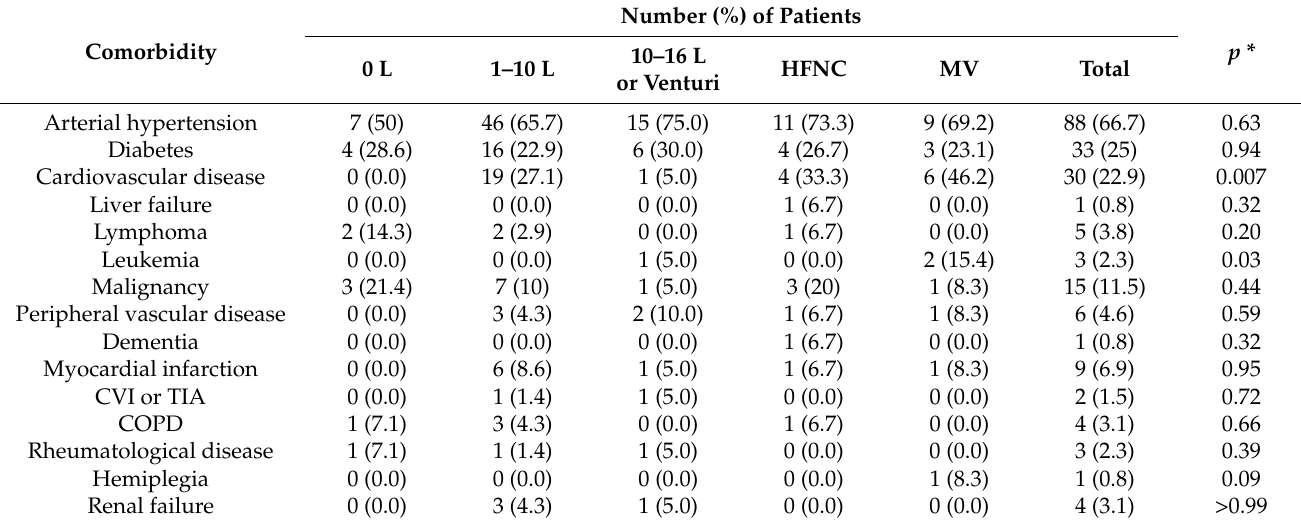
Table 2. Baseline characteristics of patients according to comorbidity and respiratory support modality used.